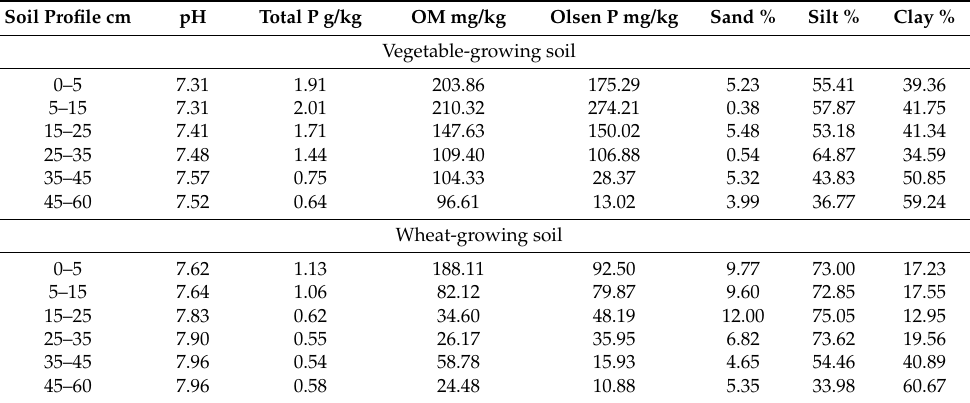
Table 2. Properties of soils used in the